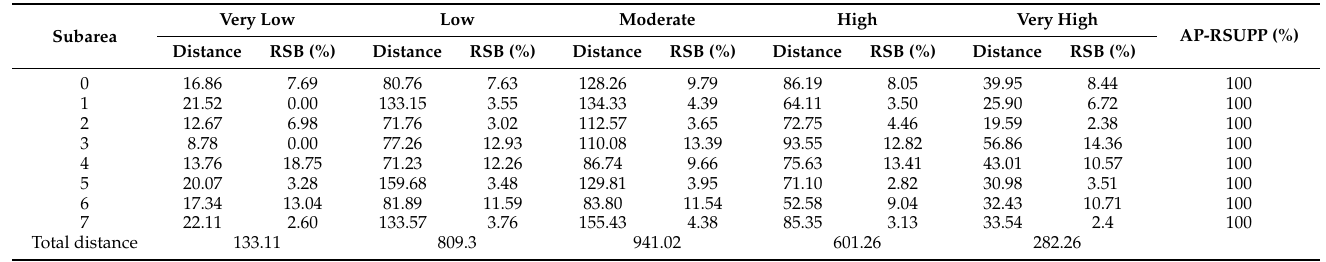
Table 8. Percentage of risk levels patrolled by RSB and UPP paths within same flight distance in each subarea.